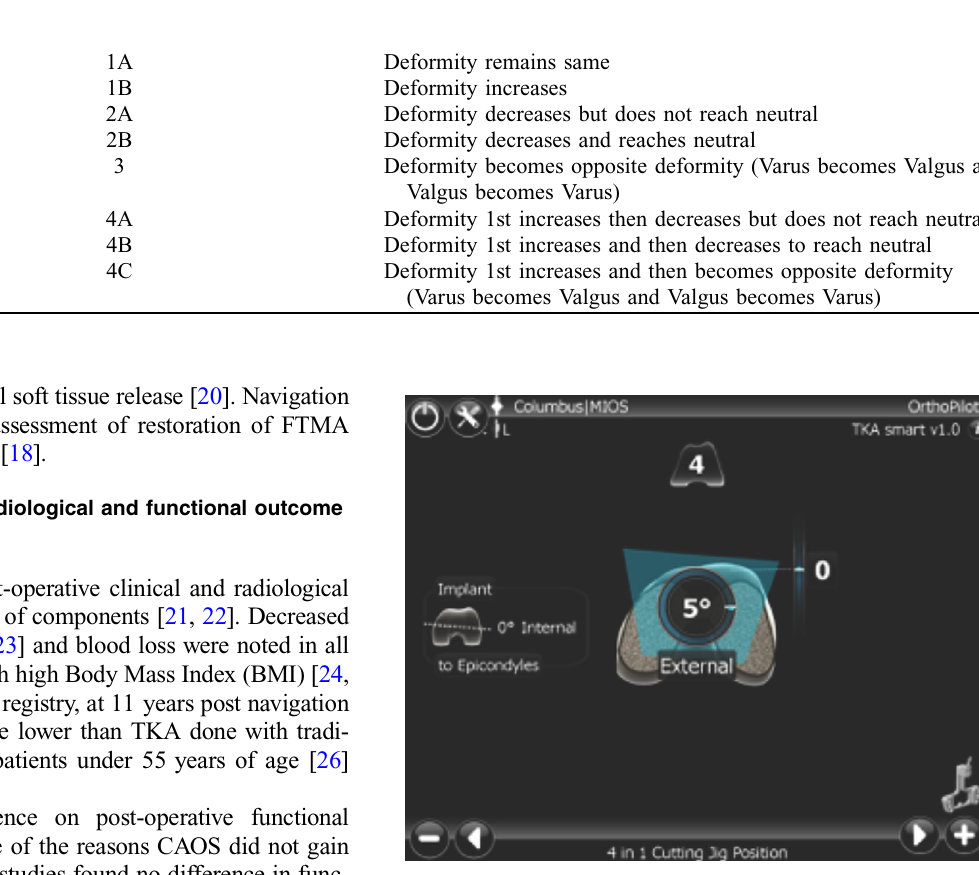
Figure 1. The implant size and positioning of the rotational position of femoral cutting